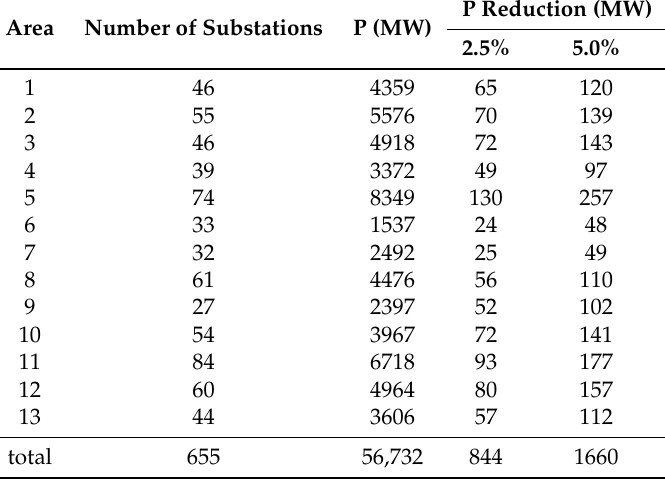
Table 7. Expected load reduction due to CVR deployment in the Korean power system by